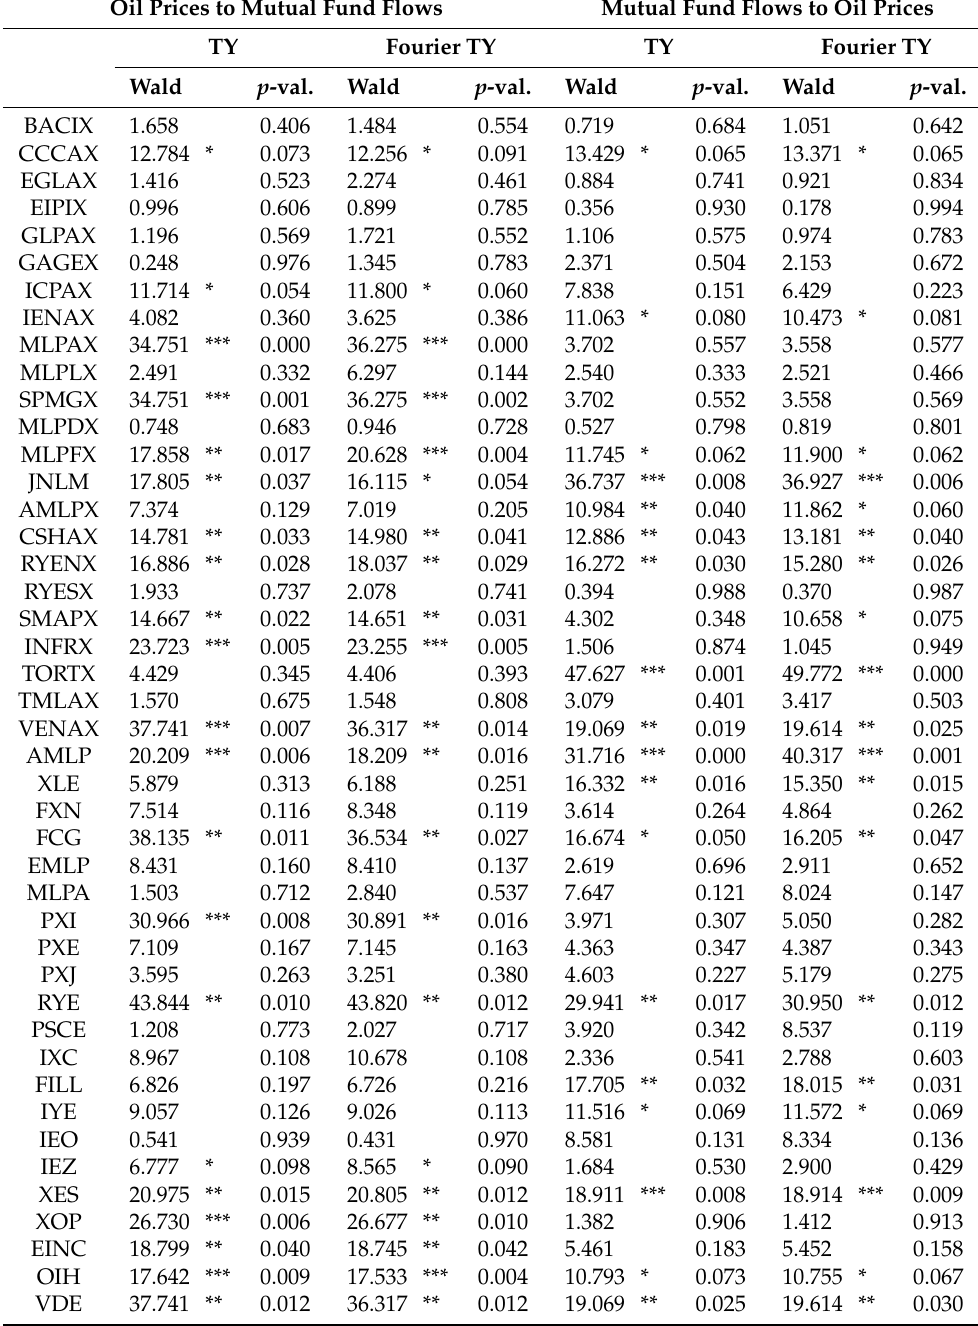
Table 4. Results for price transmission between oil prices and mutual fund